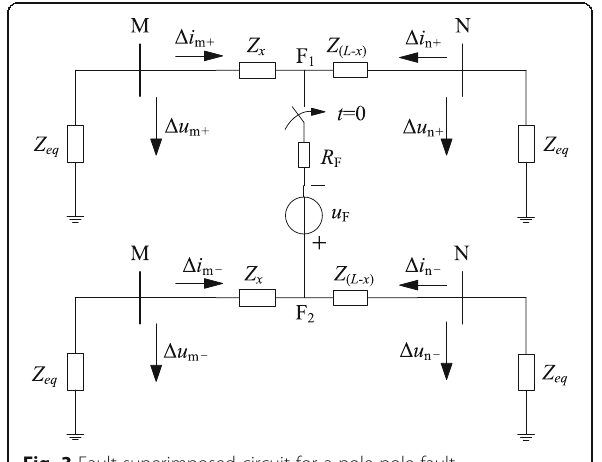
Fig. 3 Fault superimposed circuit for a pole-pole fault